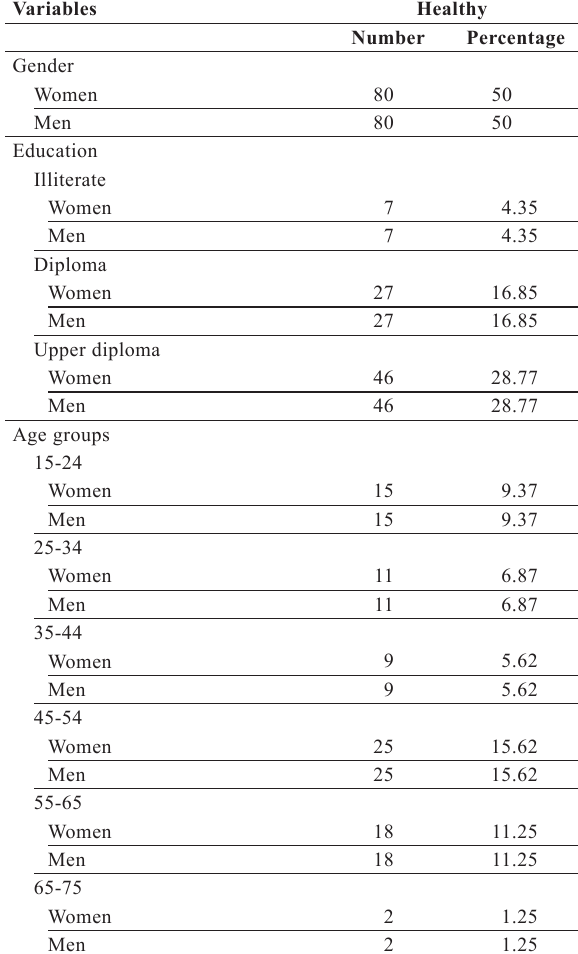
Table 1. Demographic variable of age and education in men and